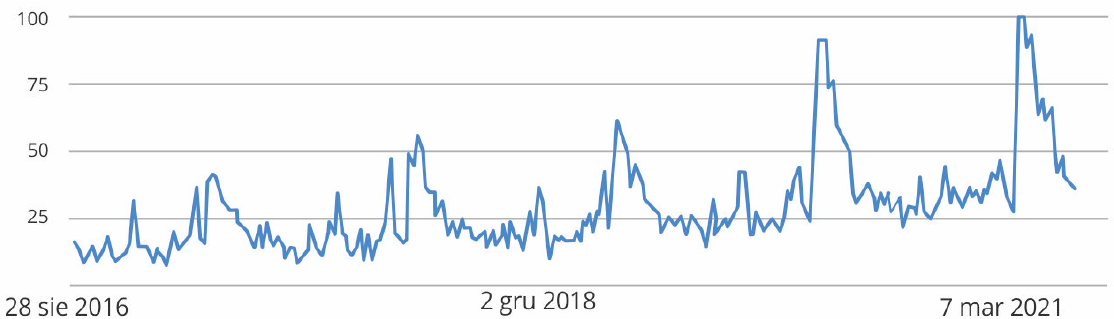
Figure 4. Frequency of searches for the keyword “litany” over the last five years; source: Google Trends, https://www.google.com/trends (accessed on 23 August 2021).